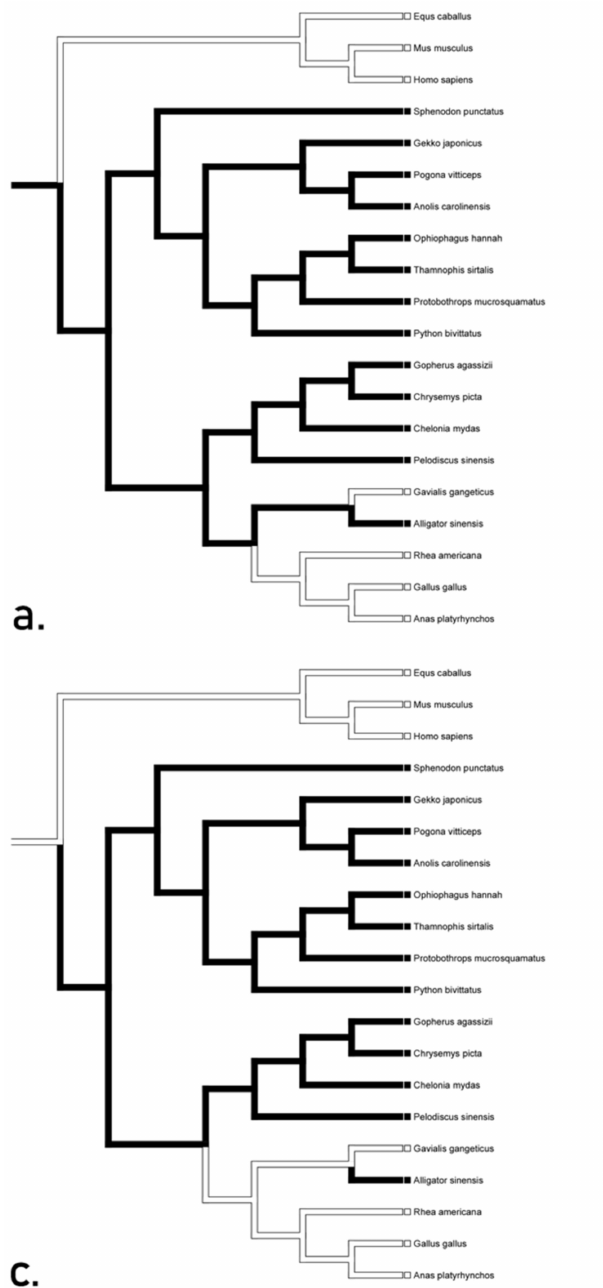
Figure 4. Character optimization of TLR 14 using accelerated ( a ) delayed ( b ), and mixed ( c ) transfor- mations that unequivocally presented the conservation of the TLR 14 throughout Reptilia, along with a loss in Gavialis . Accelerated and mixed transformations suggest conservation throughout Reptilia, while delayed transformation hypothesized convergence between major